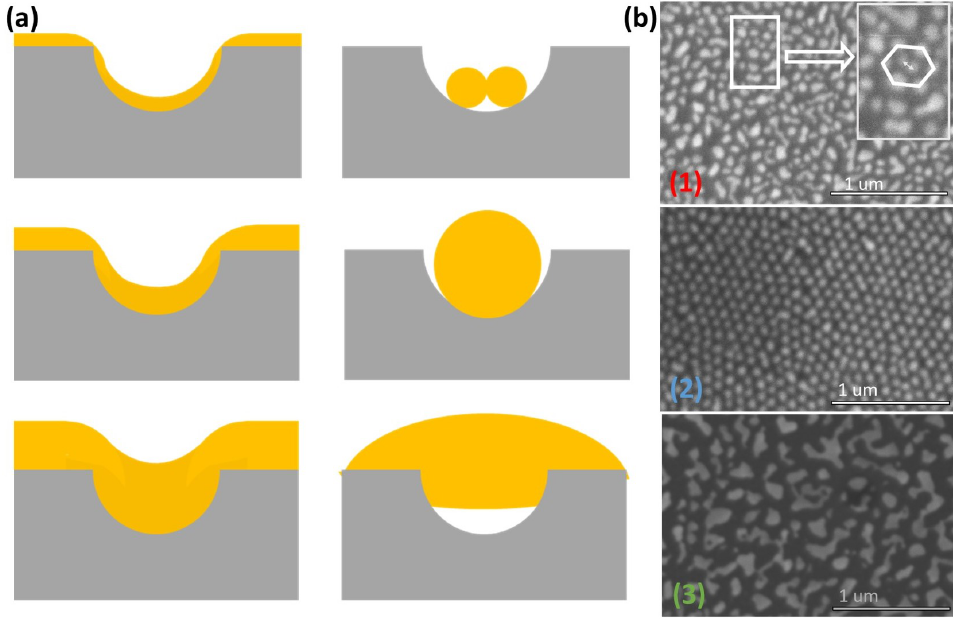
Figure 9. Morphology evolution following de-wetting process: ( a ) Schematic of conformal films of varying thickness on the dimpled surface; ( b ) Corresponding SEM images of nanoparticle arrays for films of varying